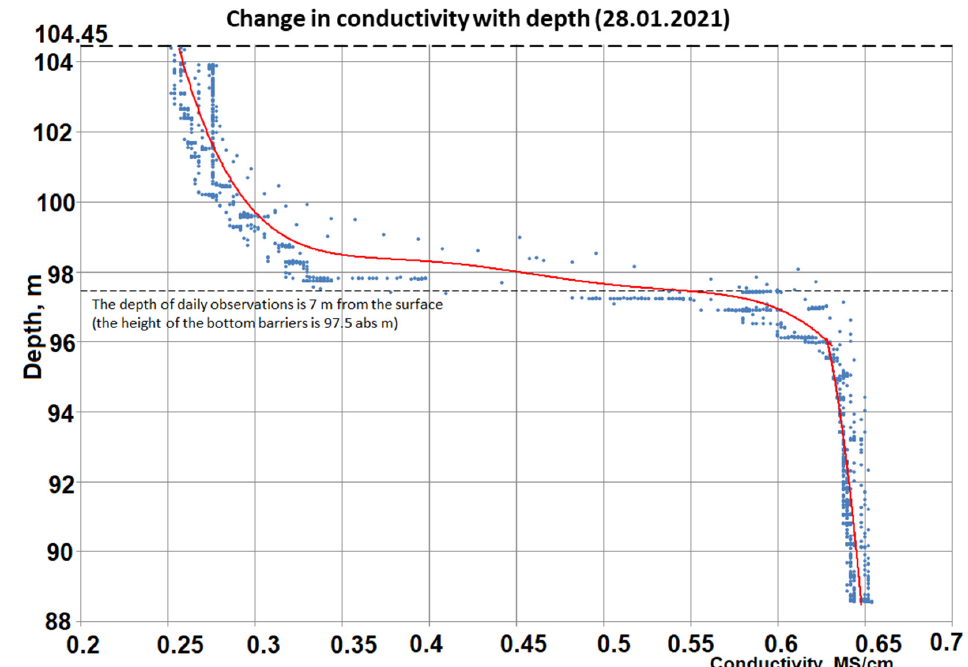
Figure 2. Change of conductivity with depth (28 January 2021).